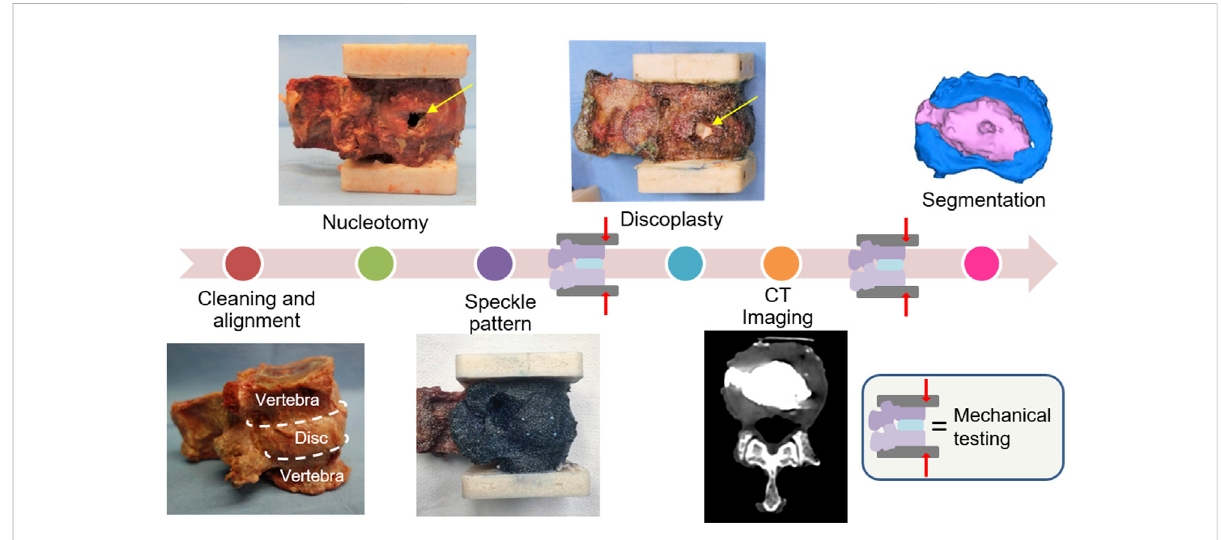
FIGURE 1 Experimentalwork fl owofthestudy.The specimenswerepreparedwith ahigh-contrastspecklepatternto allowmeasuringdisplacementsand strains under load with digital image correlations. Each specimen underwent biomechanical testing (under the same loading conditions) after nucleotomy and after simulated percutaneous cement discoplasty. The cement injected was investigated on CT